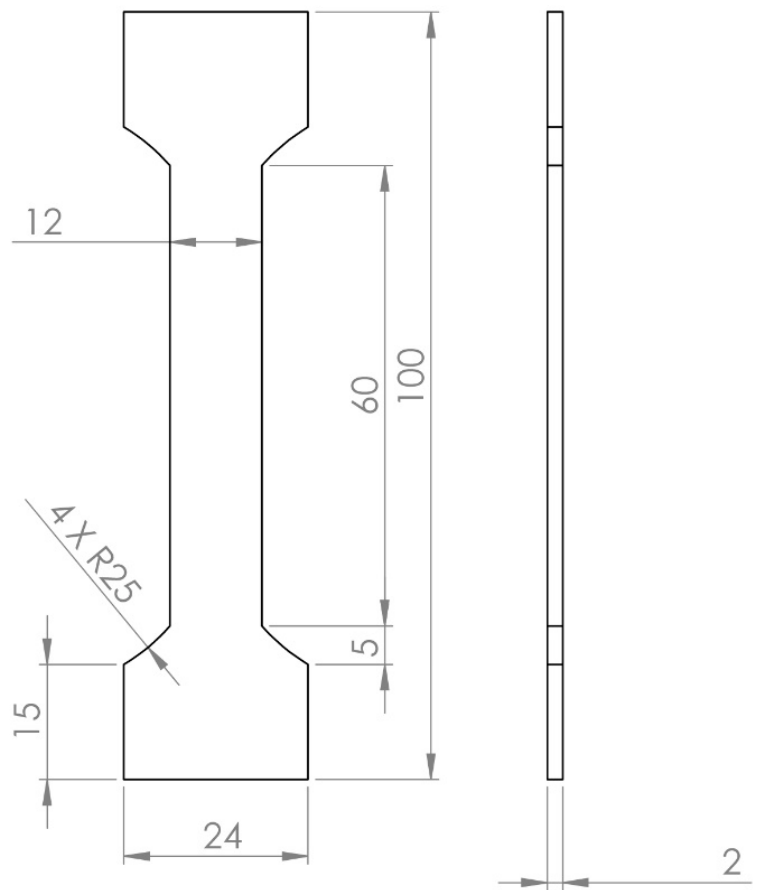
Figure 14. Specimen dimensions for the tensile test.